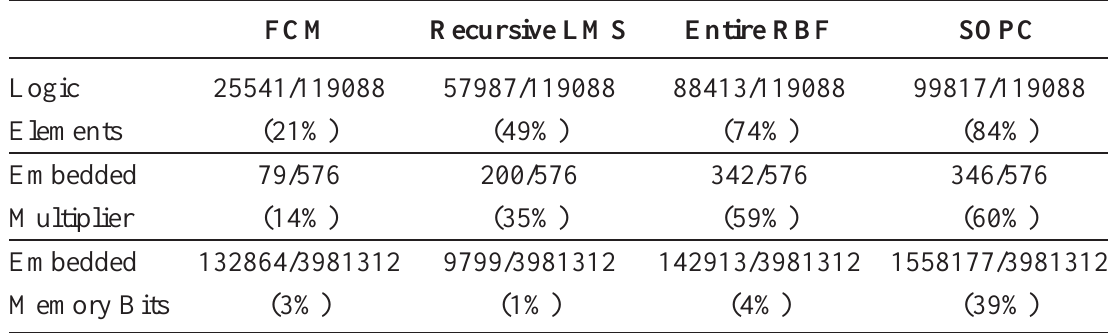
Table 7. The Hardware Resource Consumption of the Proposed Architecture with n = 4 × 4 , c = 8 and q = 1 .